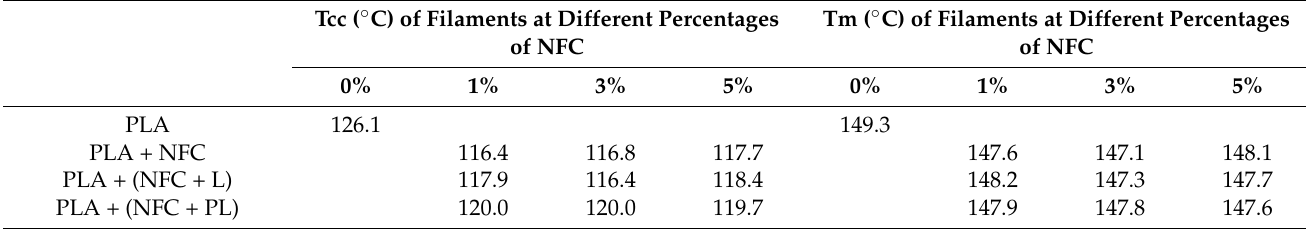
Table 8. Temperature of cold crystallization and melting by DSC analysis.